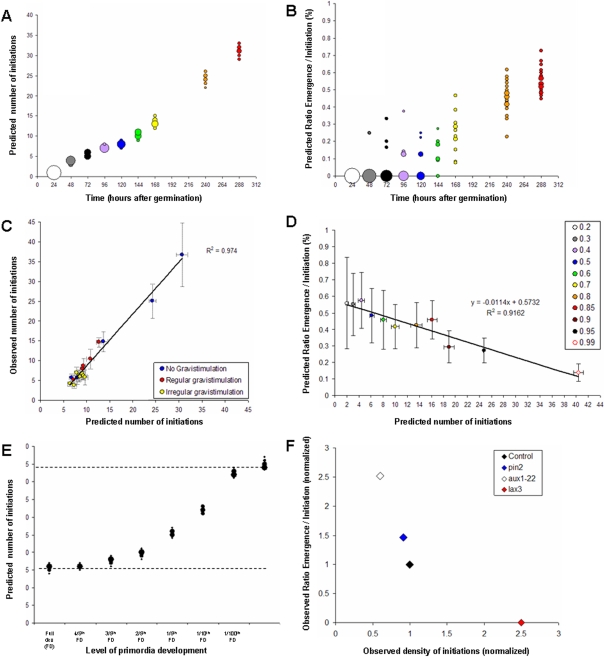
Mechanistic model calibration and predictions.(A & B) Initiation and emergence in the model were calibrated according to the observed mean initiation and emergence level (see figure 2). Runs of 20 simulations were done for each condition. Data point size indicates the relative number of simulations giving the same output. (C) Fit between model prediction and observation for various gravistimulation patterns (see Supplementary Figure S4 for additional details on the gravistimulation patterns). Runs of 20 simulations were done for each condition. (D) Predicted emergence rate and initiation level as a function of apical reflux. The color code indicates the reflux efficiency at the apex (reflux efficiency ranging from 20% to 99%). Runs of 20 simulations were done for each condition. (E) Predicted initiation level as a function of development level of primordia. Development of primordia in the model was either full or arrested at various level ranging from 4/5th of full development to no development at all. Runs of 20 simulations were done for each condition. Data point size indicates the relative number of simulations giving the same output. (F) Observed initiation and emergence densities in mutants and wild-type Col-0. Initiation and emergence densities were scored for the mutants pin2 and aux1, and normalized in regard to the emergence density of wild-type Col-0 plants. Data for the lax3 mutant were provided by Pr. Malcolm Bennett. Each data point corresponds to a set of more than 20 seedlings.